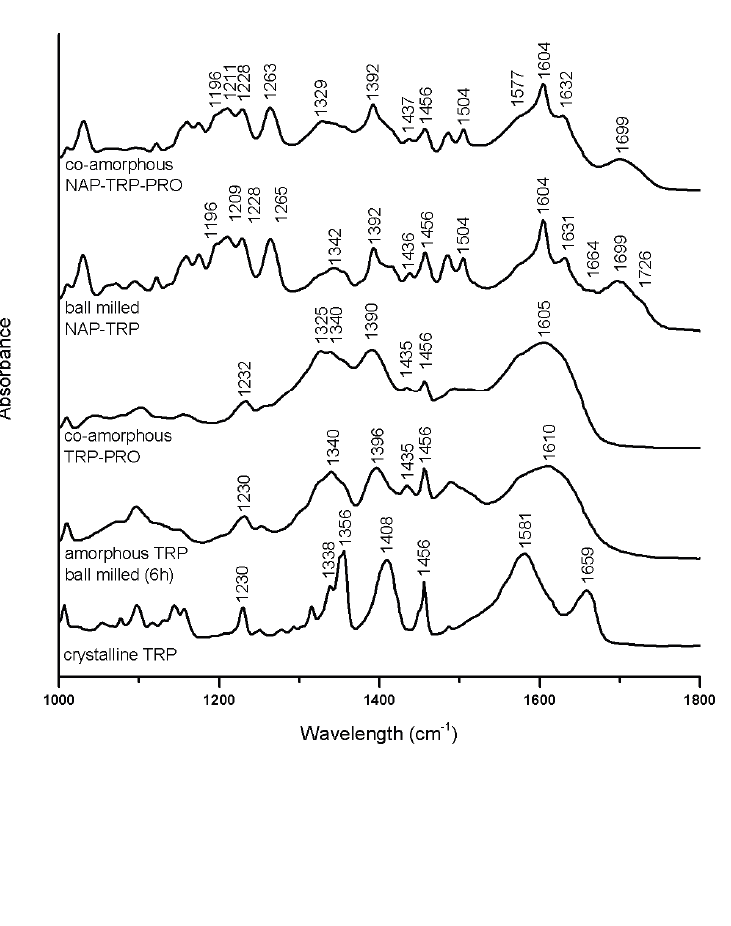
Figure 6. FTIR spectra of crystalline TRP, amorphous TRP ball milled for 6 h,